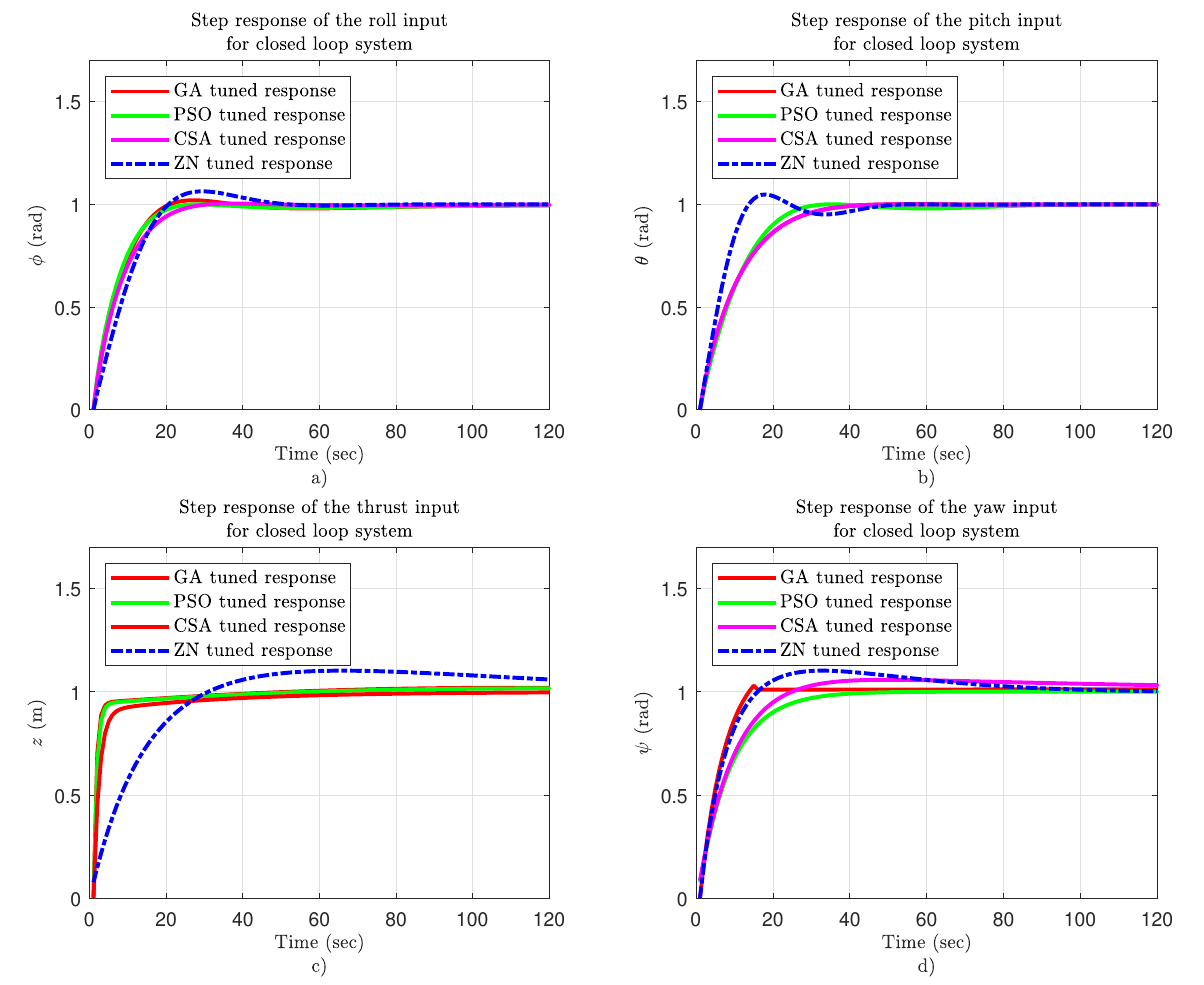
Figure 19. Simulated output responses of the roll, pitch, yaw and thrust inputs of a quadcopter using ( a ) GA, ( b ) PSO, ( c ) CSA and ( d ) ZN